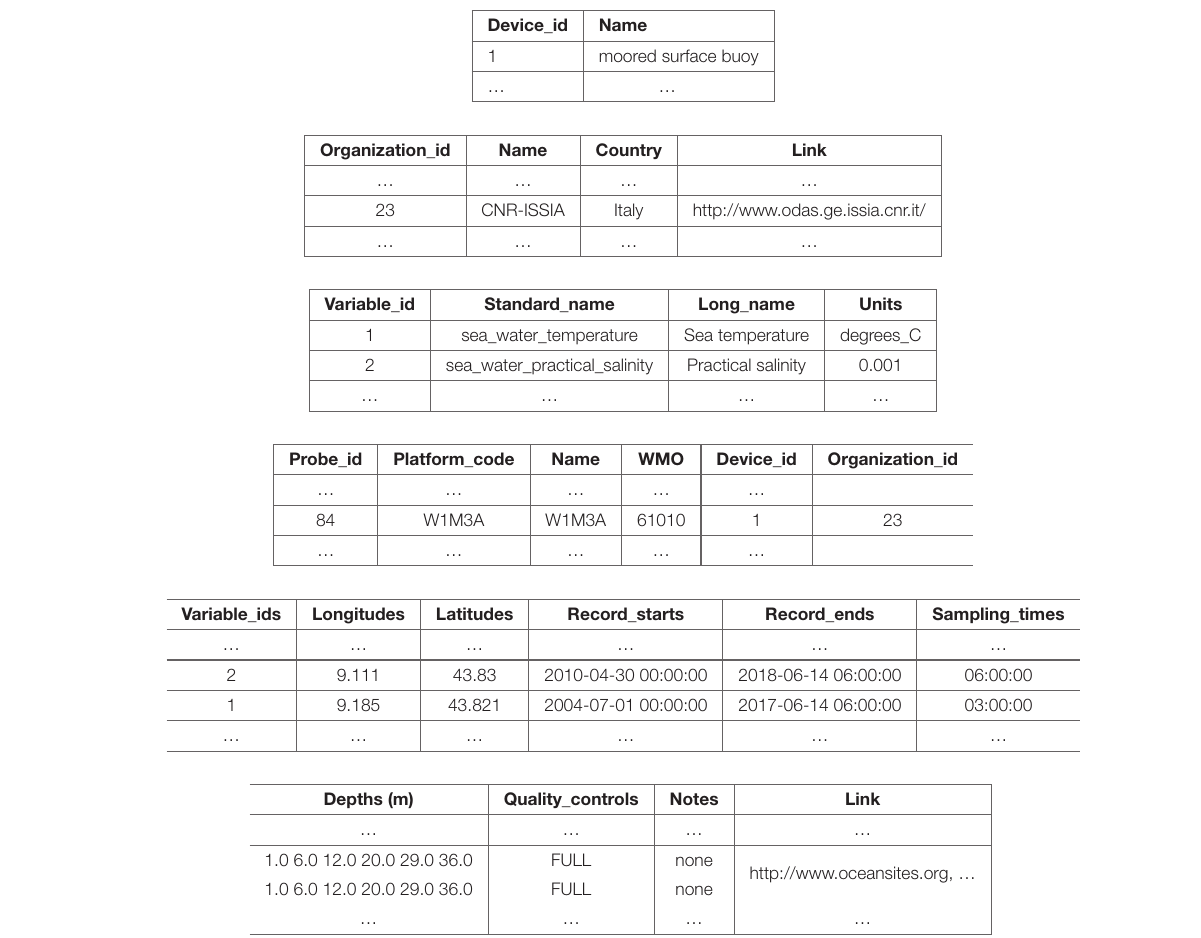
TABLE 1 | Excerpt of in situ relational metadatabase produced by SOURCE.